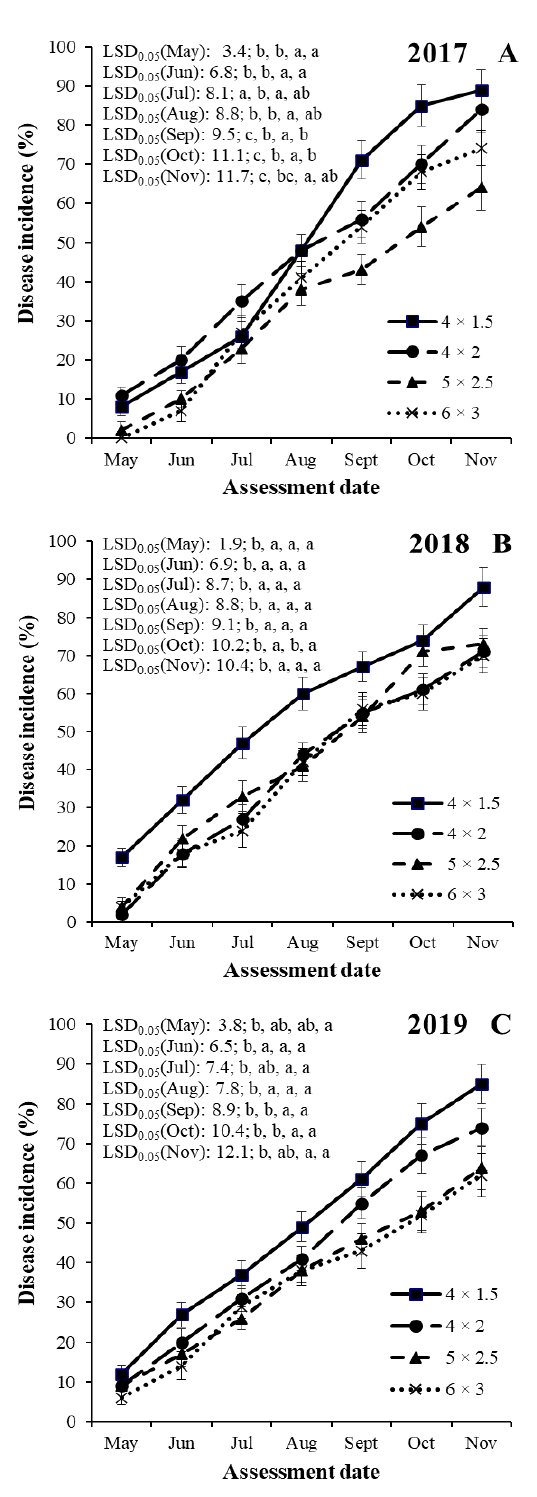
Figure 1. Temporal dynamics of shot hole incidence on plum cultivar ‘Čačanska lepotica’ in four training systems (4 × 1.5, 4 × 2, 5 × 2.5 and 6 × 3 m) in the years of 2017 ( A ), 2018 ( B ) and 2019 ( C ) at seven assessment dates (May, Jun, Jul, Aug, Sept, Oct and Nov) in an integrated plum orchard at Debrecen-Pallag, Eastern Hungary. Values within the given cultivar coupled with different letters are significantly different among each training system at p = 0.05, according to LSD t -tests. First, second, third and fourth letters of significance after LSD 0.05 values correspond to training systems of 4 × 1.5, 4 × 2, 5 × 2.5 and 6 × 3 m, respectively.